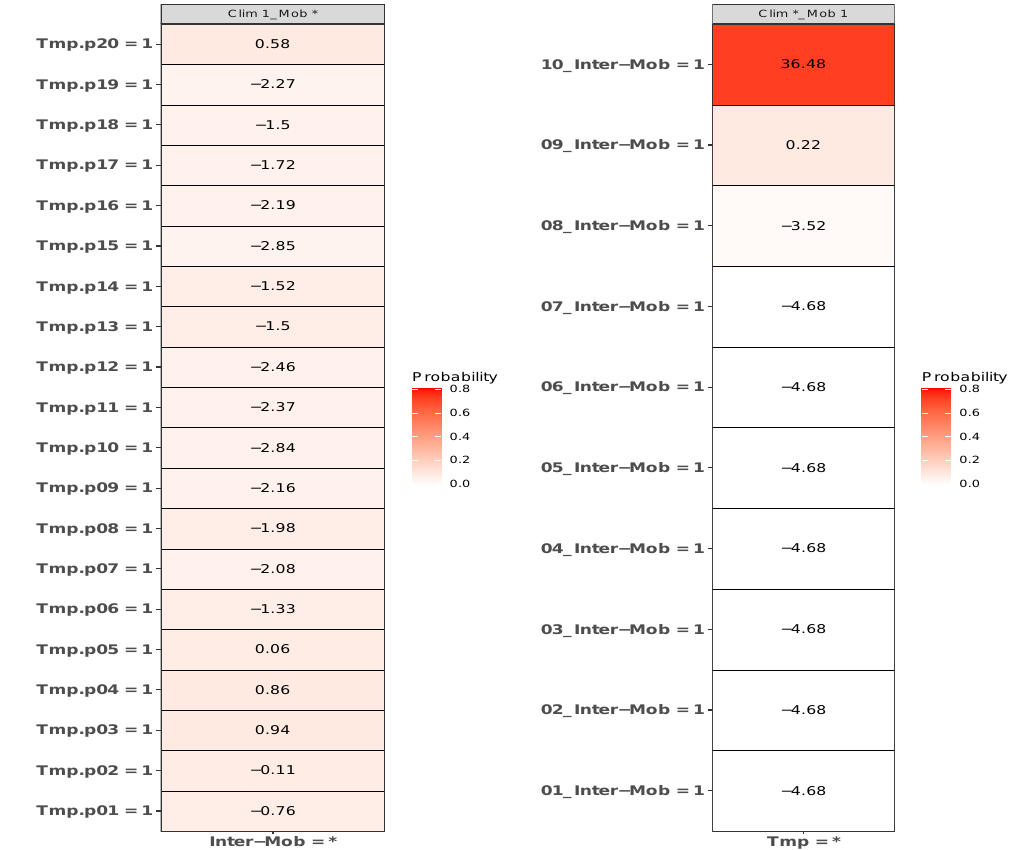
= 1 ) , ε ( C = 1 ) , P ( C = 1 ) and P ( C X m X n X m i j i | | | = Average annual temperature and X n i